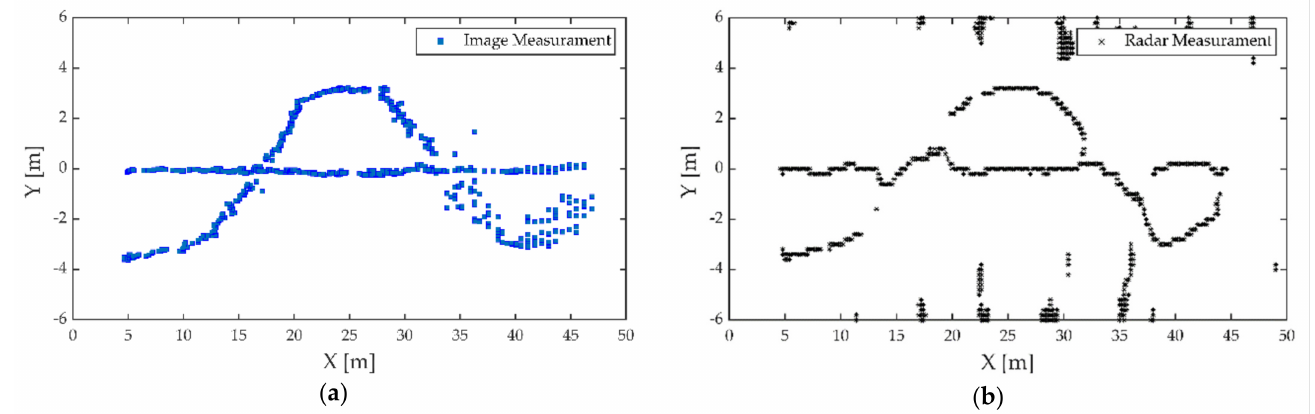
Figure 11. Detection results of targets: ( a ) camera; ( b ) radar.